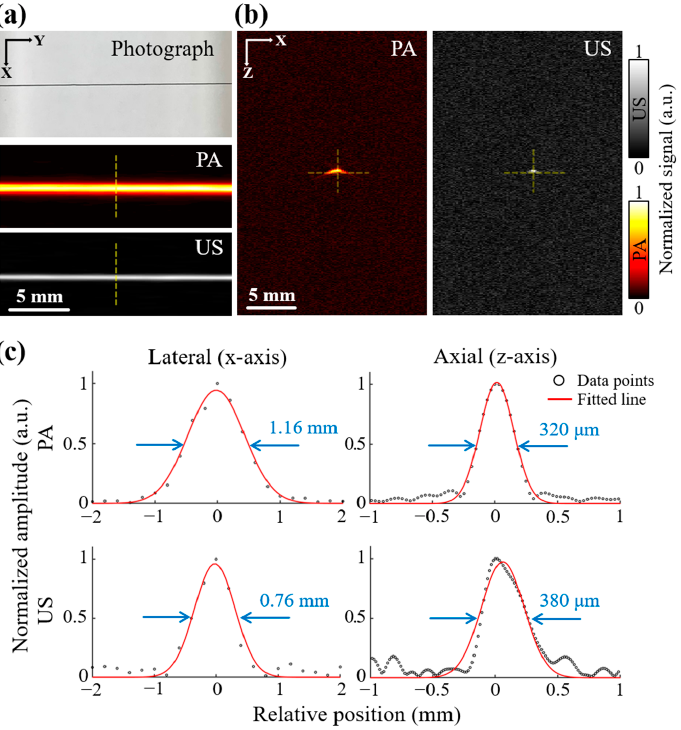
Figure 2. Performance benchmark of the PA and US imaging system. ( a ) Photograph, PA MAP, and US MAP images of the resolution phantom. The scale bars are equal for X and Y directions. ( b ) Cross-sectional PA and US images correspond to yellow dashed lines in (A). The scale bars are equal for X and Z directions. ( c ) Data points and Gaussian fitted lines along the lateral and axial direction. Resolutions are calculated as the full width at half maximum of each fitted line. Based on the geometry of the US transducer, the theoretical lateral and axial resolutions are 610 and 310 µ m, respectively. PA, photoacoustic; US, ultrasound; MAP, maximum amplitude